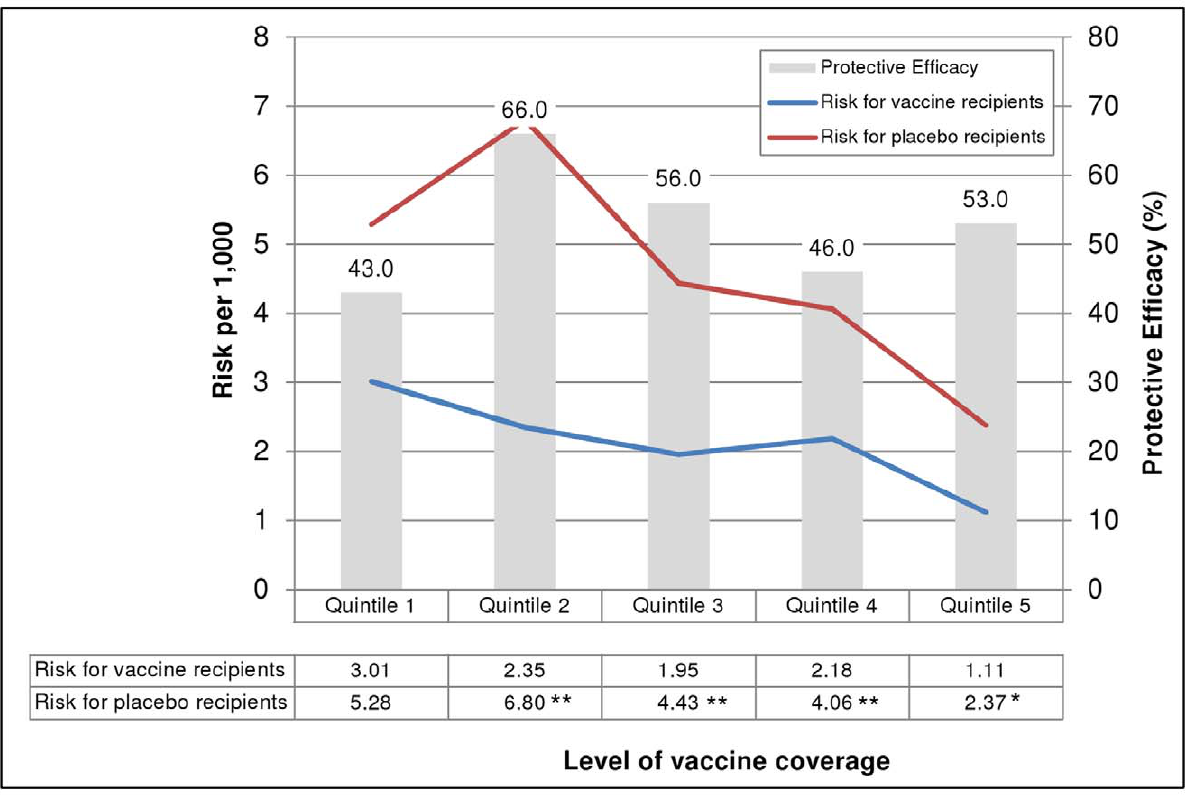
Figure 4. Risk of cholera and protective efficacy of killed oral cholera vaccines, by level of vaccine coverage in bari -level social networks. **p , 0.01 for the difference in risk between vaccinees and placebo recipients; * p , 0.05 for the difference in risk between vaccinees and placebo recipients. Note: Quintile values are as follows: , 28.7, 28.7-37.9%, 38.0-44.9%, 45.0-51.8%, . 51.8%. GREY bars show vaccine protective efficacy by quintile of vaccine coverage within social networks developed using bari-level kinship connections. The number shown above each bar is the calculated protective efficacy. The RED line indicates the risk of cholera for placebo recipients while the BLUE line indicates the risk of cholera for vaccine recipients by quintile of vaccine coverage within social networks. The numbers contained in the table below the graph indicate the calculated cholera risk for each group. An asterisk (**) indicate that the cholera risk per 1,000 was significantly different between the placebo and vaccine groups (e.g., the confidence intervals for the two calculated rates did not overlap). Quintiles show the proportion of a person’s social network that was vaccinated (e.g., for quintile 1, , 28.7% of people in an individual’s social network were administered the cholera vaccine).